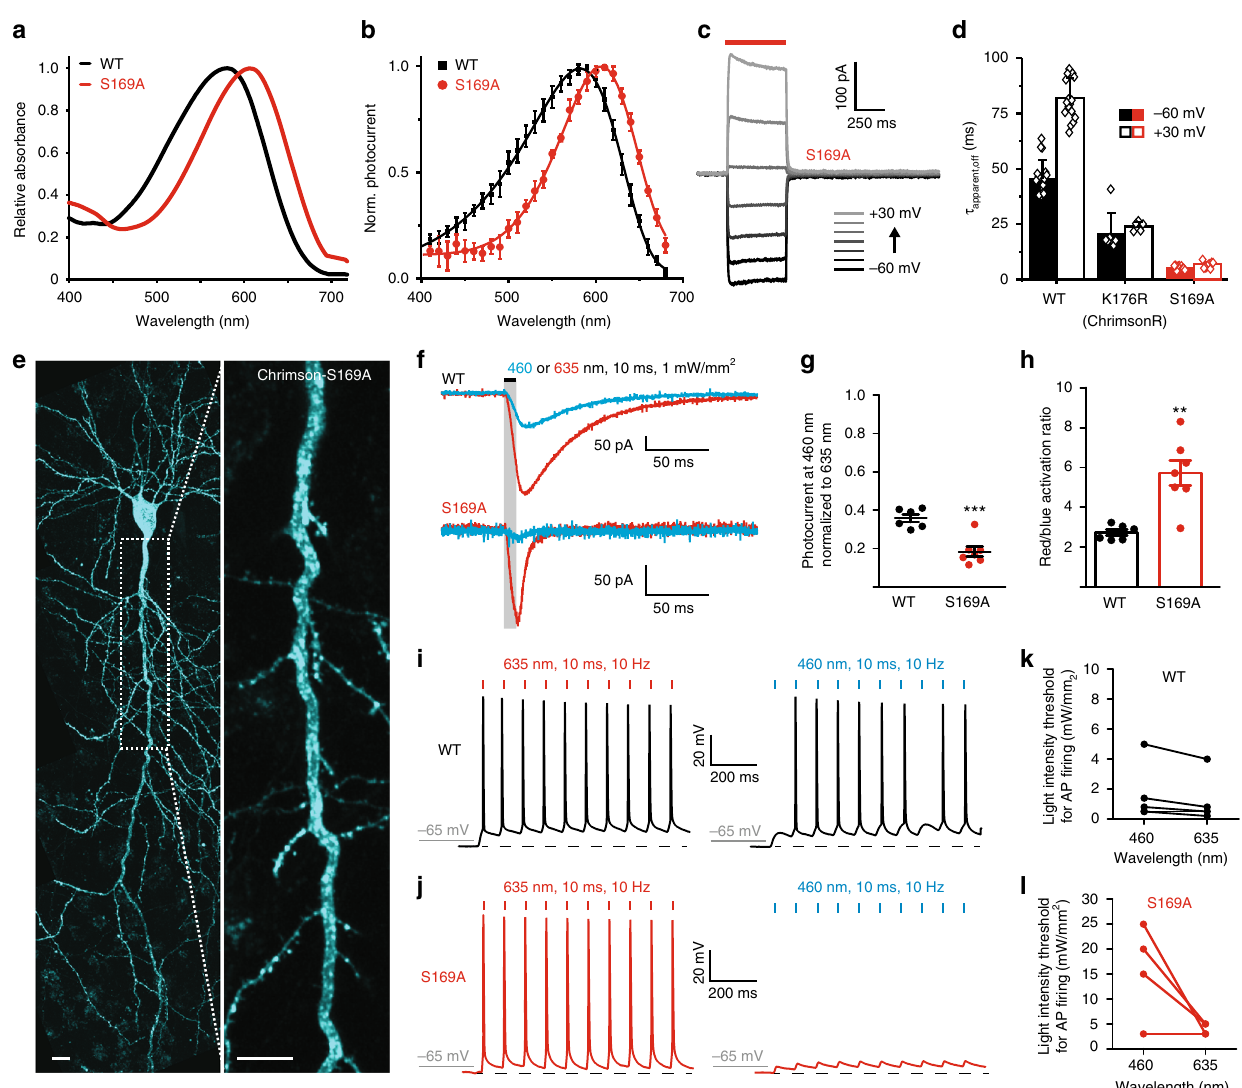
Fig. 6 Chrimson-S169A in rat CA1 pyramidal cells. a , b Red-shifted absorption spectrum ( a ) and action spectrum ( b ) of Chrimson S169A (ChrimsonSA) (Mean ±SD; n = 7; 10ms illumination of equal photon counts, symmetric 110 mM NaCl, pH e,i 7.2 and − 60mV). c , d Photocurrents of ChrimsonSA in HEK cells. Representative photocurrent traces ( c ) and channel closing kinetics ( d ) at the same ionic conditions as in ( b ) are shown. e CA1 pyramidal neuron heterogeneously expressing ChrimsonSA-mCerulean, 5 days after electroporation (stitched maximum intensity projections of two-photon images). The inset shows a magni fi ed view of the apical dendrite. The scale bars indicate 10 μ m. f Representative photocurrent traces of Chrimson-WT (top) and ChrimsonSA (bottom) expressing CA1 pyramidal cells evoked with either 635nm (red trace) or 460 nm (blue trace, 1mW/ mm 2 ) light. The ChrimsonSA traces were scaled to WT Chrimson g Relative photocurrent responses of WT Chrimson and ChrimsonSA to blue light (460nm, 10ms, 1mW/ mm 2 ). Values were normalized to the response to red light (635nm, 10ms, 1mW/ mm 2 ). Dots represent single cells. Lines show mean±SEM (n WT = 6; n S169A = 7). h Quanti fi cation of the red/blue activation ratio. Bar plots show mean ±SEM. i , j Action potentials triggered by red light pulses at a frequency of 10Hz in cells expressing WT Chrimson ( i ) and ChrimsonSA ( j ) at threshold light intensities of 0.5 and 5mW/mm 2 , respectively. Using the same light intensities, the action potentials were triggered by blue light in WT, but not in the ChrimsonSA. Dashed lines represent the membrane resting potential. k , l The light intensities at 460 nm and 635nm required to reach the action potential threshold in neurons expressing WT Chrimson ( k ) or ChrimsonSA ( l